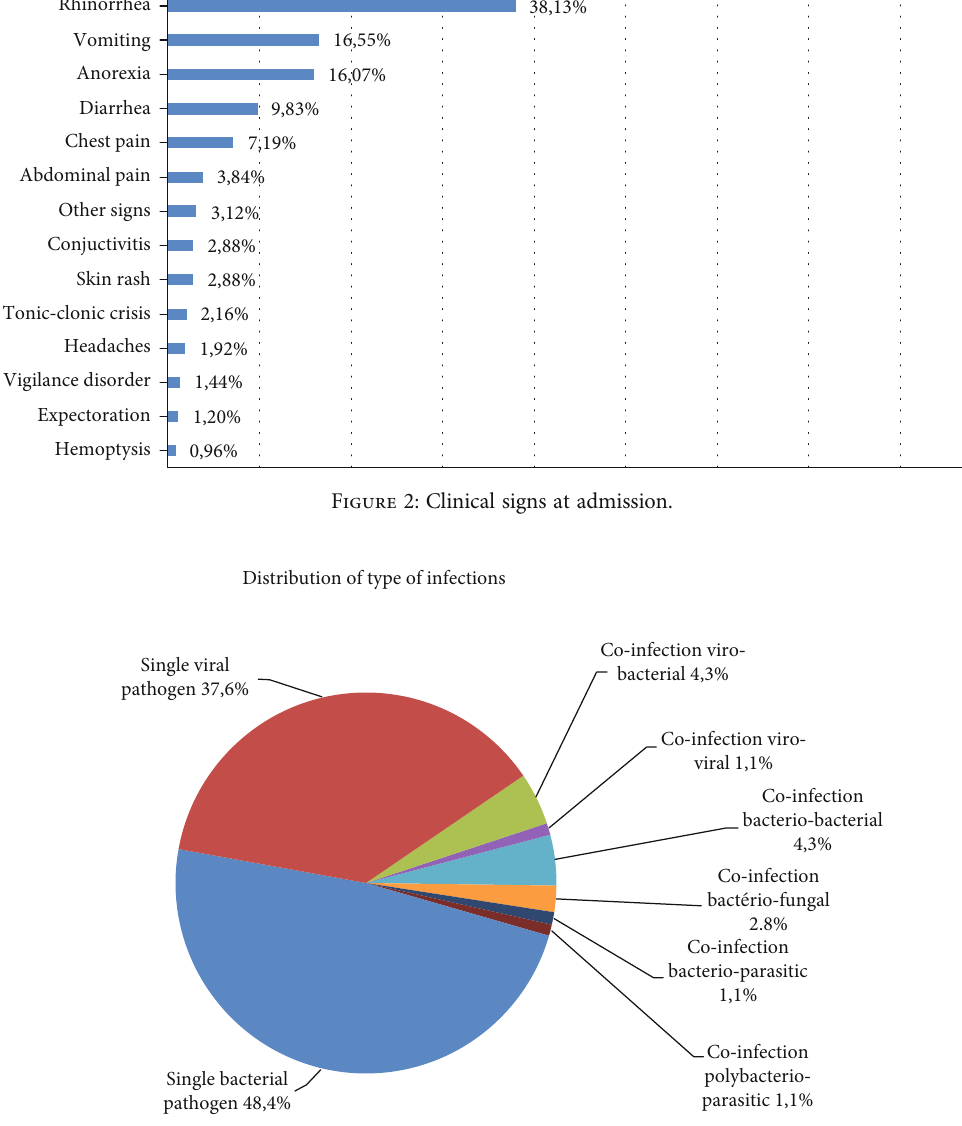
Figure 3: Distribution of type of